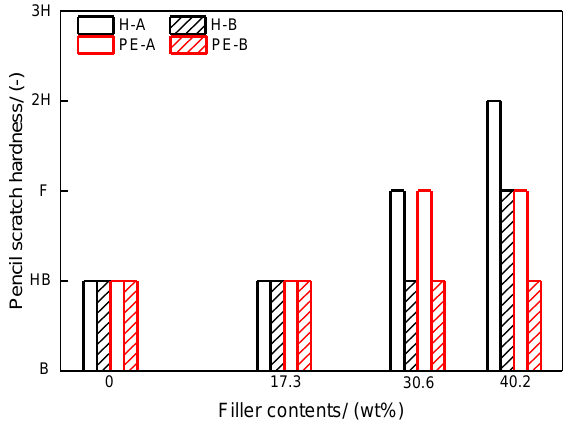
Figure 9. Pencil scratch hardness of samples.